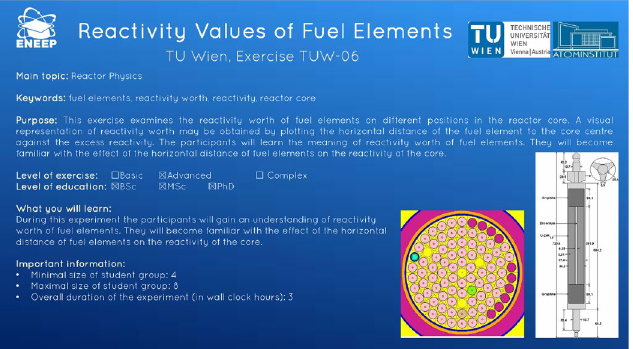
Fig. 9 . Example of experiment presentation materials – TU Wien, Reactivity values of fuel elements.